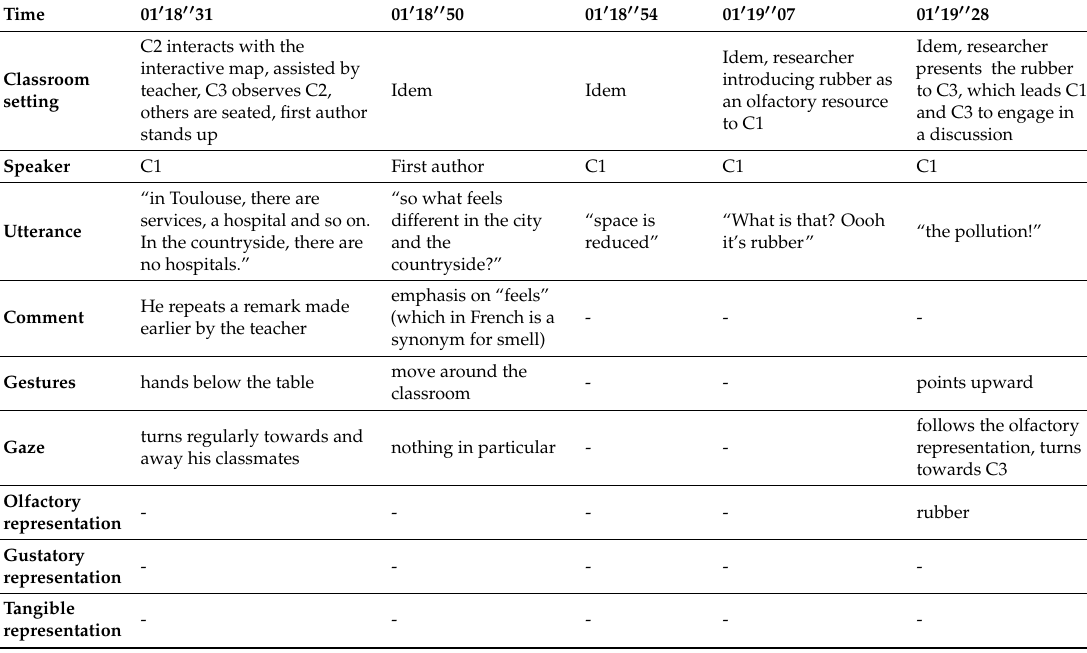
Table A1. Excerpt from the second phase of our analysis. It consisted of the analysis of sub-units of interactions, identifying the resources used by the children during their meaning-making